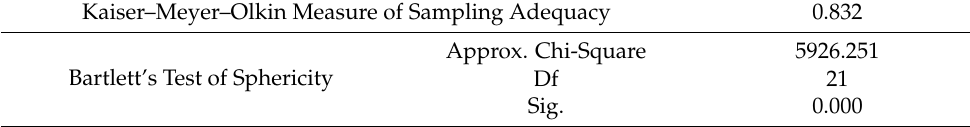
Table 1. KMO and Bartlett’s